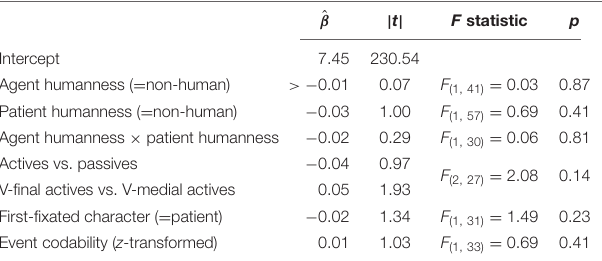
TABLE 3 | Results from linear mixed effects regression model predicting log-transformed speech onset